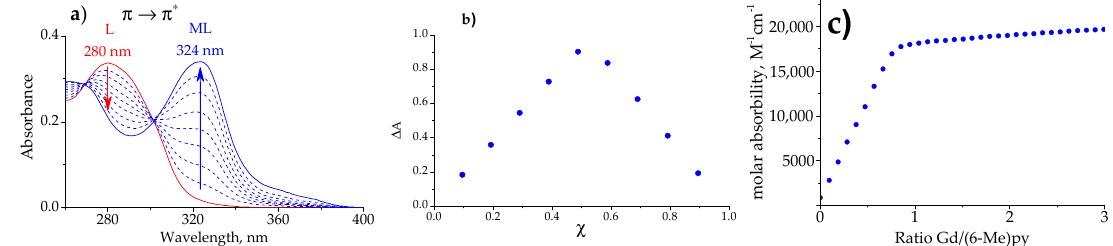
Figure 4. Spectrophotometric titration of 3c with Gd(NO 3 ) 3 ∙ 6H 2 O in acetonitrile, where 1 μ L of 3.82 mM titrant solution Gd(NO 3 ) 3 ∙ 6H 2 O were added to 2 mL of 2.01 × 10 − 2 mM 2c (0–3.0 equiv.). ( a ) UV-vis titration of 2c observed upon the addition of 0–1.0 equiv. of Gd(NO 3 ) 3 ∙ 6H 2 O at 25 °C; ( b ) the Job ′ s plot at 324 nm and ( c ) titration curve at 324 nm.